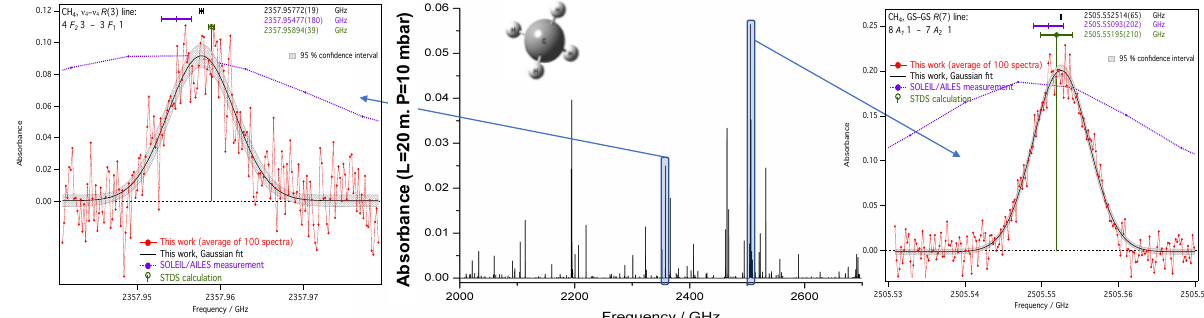
Figure 2. Central part: Absorption of ground state rotational THz lines of CH 4 induced by centrifugal distortion simulated for a pathlength of 20 m. and a pressure of 10 mbar. Left and right parts: two examples of experimental lines measured at 30 MHz resolution, P = 10 mbar and L = 150 m by FT-FIR spectroscopy using the AILES beamline of the SOLEIL synchrotron (blue solid line) and at 30 kHz resolution, P = 1.5 mbar and L = 20 m with the cw-THz photomixing spectrometer [13]. Calculations were performed using the STDS software [27], which is part of the XTDS [28] package that implements the tensorial formalism developed for spherical-top molecules in the Dijon